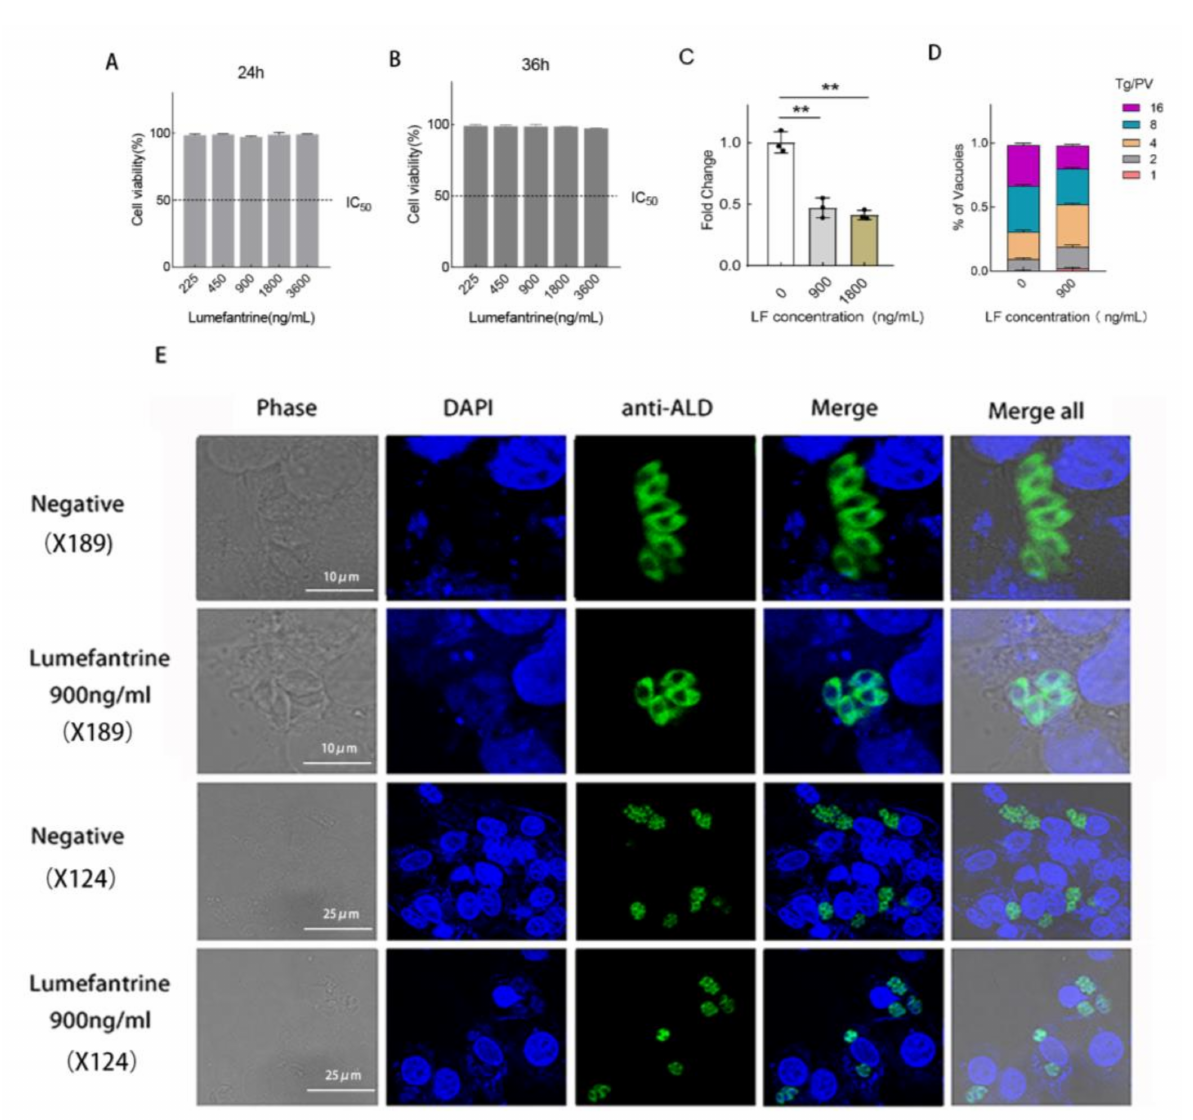
Figure 1. The cytotoxicity of lumefantrine and its inhibitory effect on T. gondii . ( A ) Cytotoxicity of lumefantrine to Vero cells after 24 h. Compared to DMEM group, no significant cell viability change was detected. Three technical replicates and two biological replicates were set up and data were represented as average ± S.D. ( B ) Cytotoxicity of lumefantrine to Vero cells after 36 h. No significant difference was observed as compared to the DMEM control. Three technical replicates and two biological replicates were set up and data were represented as average ± S.D. ( C ) Dose-response assay via qPCR. T. gondii was allowed to infect Vero cells for 4 h and subsequently treated with different concentrations of lumefantrine for 24 h. qPCR was conducted to detect T. gondii proliferation. Three technical replicates and two biological replicates were set up and data were represented as average ± S.D. (** p ≤ 0.01). ( D ) Enumeration of T. gondii parasitophorous vacuoles under the microscope following lumefantrine treatment. Three technical replicates and two biological replicates were set up. Data were represented as average ± S.D. ( E ) Confocal microscopy examination of lumefantrine- treated T. gondii . The top two rows of images were magnified 189 times and the bottom two were zoomed-out images of the top two rows with a magnification of 124 times. Anti-TgALD antibody was used to stain the cytosol of T. gondii . DAPI was used to stain nuclei. The negative controls were groups without drug